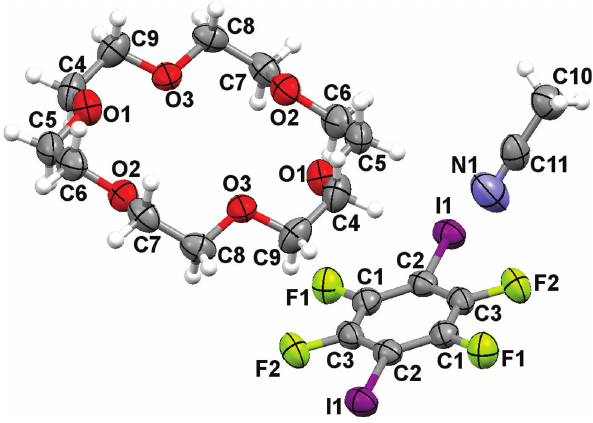
Figure 1: Molecular structure of the title complex with dispalcement ellipsoids draw at the 50% proability level.